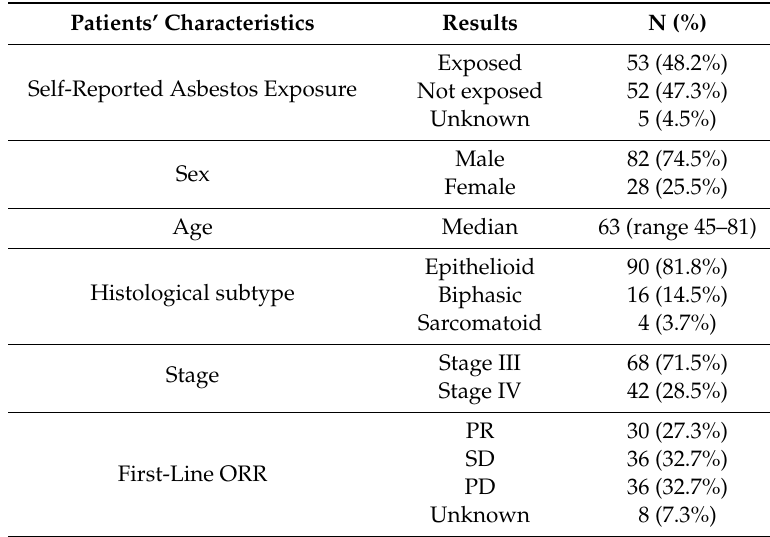
Table 1. Patients’ characteristics ( n = 110 patients). PR, partial response, SD, stable disease, PD, progressive